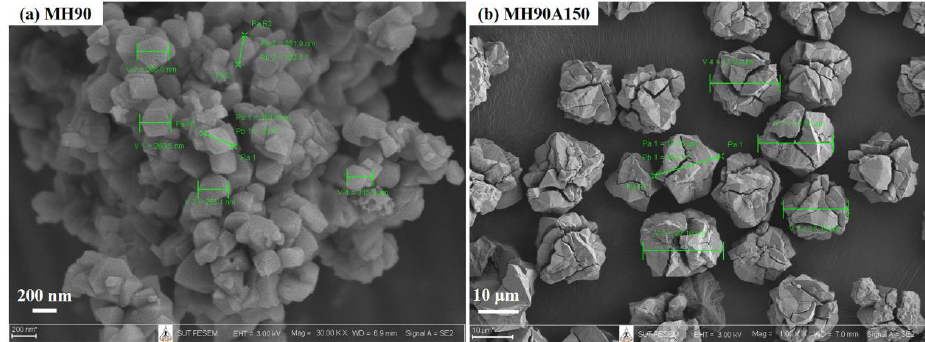
Figure 7. FESEM images of zeolites from the microwave-assisted hydrothermal method ( a ) at 90 °C for 1 h (MH90), followed by aging at room temperature for 23 h and recrystallized ( b ) at 150 °C for 1 h (MH90A150).